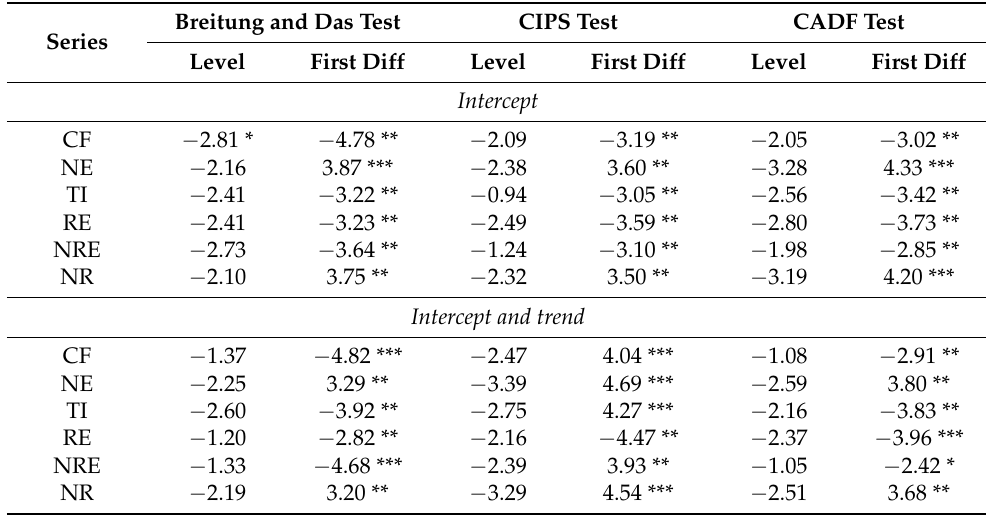
Table 5. Second generation panel unit root